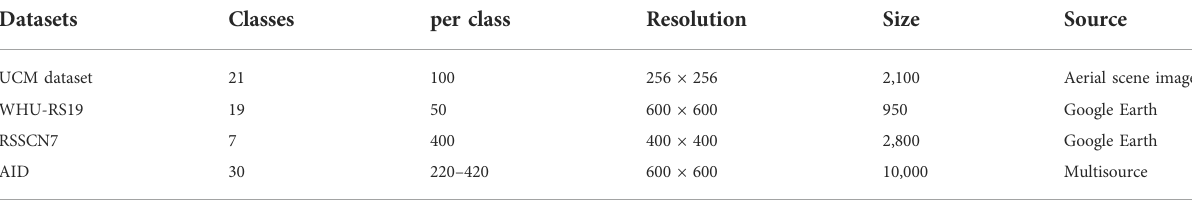
TABLE 1 The mainstream public remote sensing image datasets.